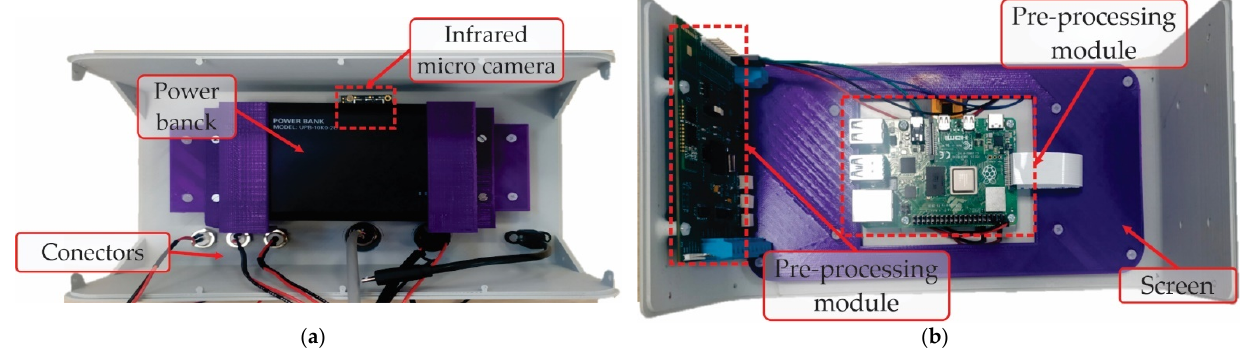
Figure 12. Smart sensor, physical system, inside views, in ( a ) front view and in ( b ) back view.